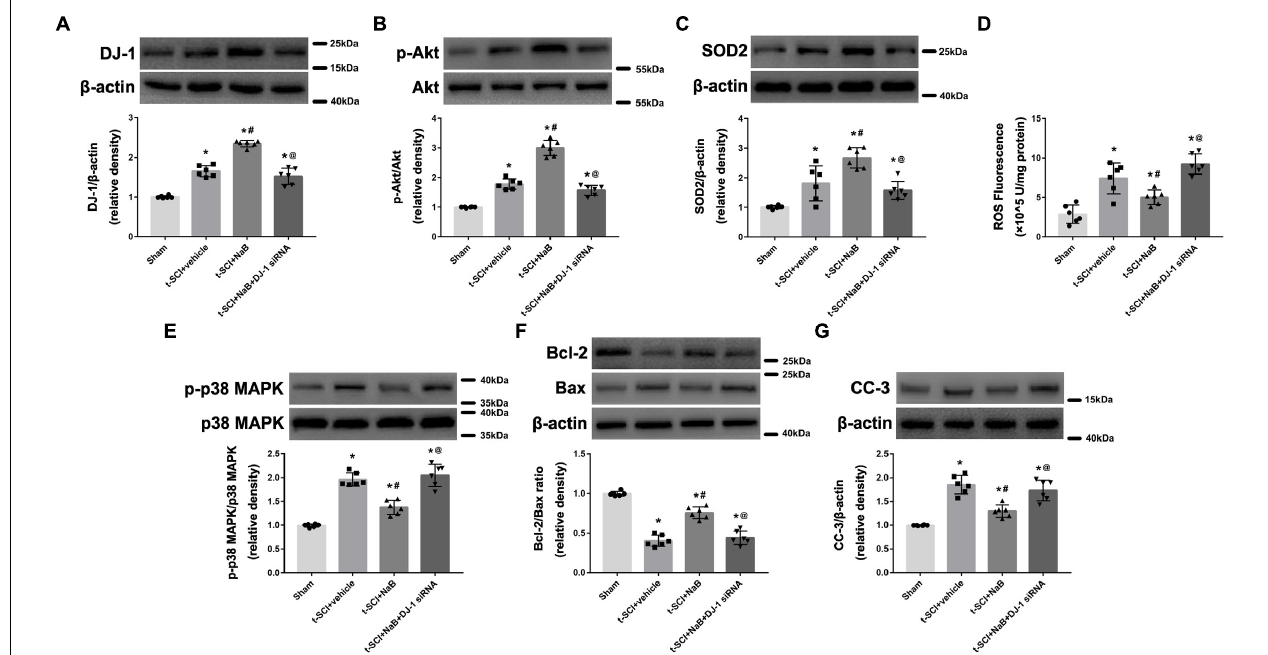
FIGURE 5 | Representative Western blots showing the protein levels in each group at 24 h post-injury. Treatment with NaB significantly increased the levels of DJ-1, p-Akt, and SOD2 (A–C) . Treatment with NaB also significantly decreased the ROS level, p-p38 MAPK/p38 MAPK ratio, and CC-3 level and elevated the Bcl-2/Bax ratio (D–G) . These effects were significantly reversed by DJ-1 siRNA injection (A–F) . There were no differences in protein and ROS levels between the t-SCI + vehicle and t-SCI + NaB + DJ-1 siRNA groups (A–G) . N = 6 for each group. Data is expressed as mean ± SD and analyzed by one-way ANOVA and Bonferroni’s post hoc multiple comparisons test. ∗ p < 0.05 versus sham; # p < 0.05 versus t-SCI + vehicle; @ p < 0.05 versus t-SCI +